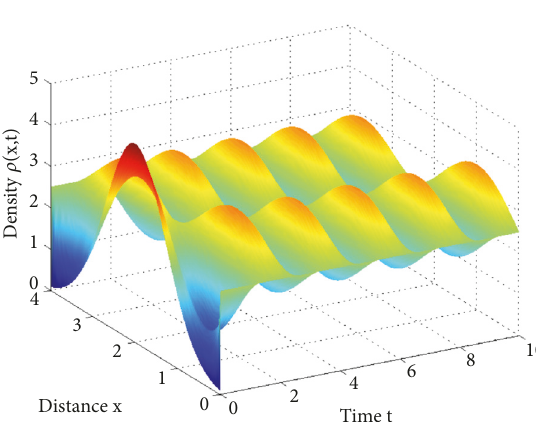
Figure 7: Finite-time tracking control with reference 𝑅 = 2.5 + sin (0.5𝜋𝑥) cos (𝜋𝑡) .